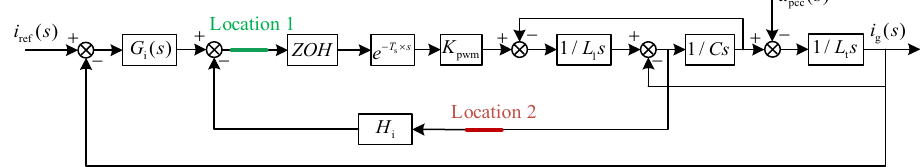
Figure 7. Insertion position of delay compensation function.